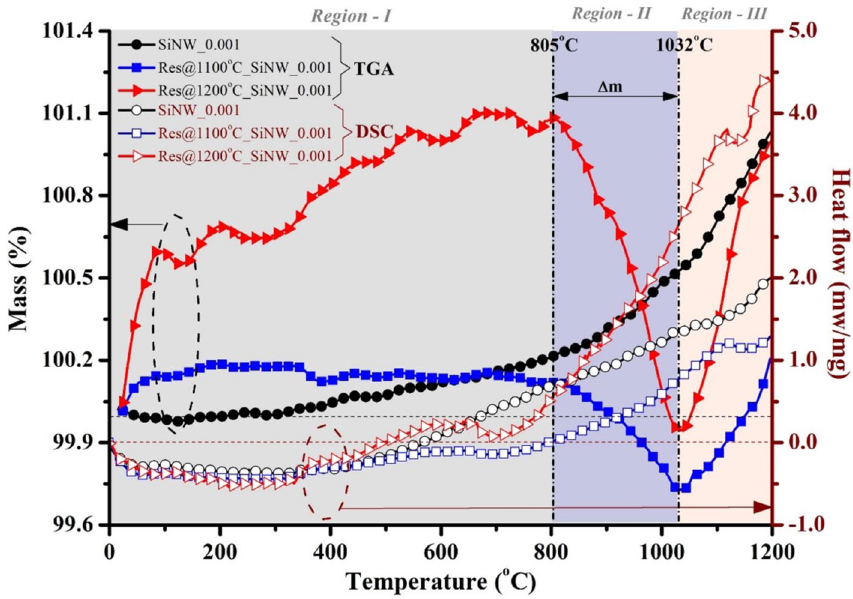
Figure 4. TG-DSC curve of pristine and sintered SiNWs. Thermogravimetry (TG) analysis highlights the % mass gain or loss in the heat treatment process. The differential scanning calorimetry (DSC) analysis gives heat flow, i.e., an exothermic or endothermic reaction occurs during heat